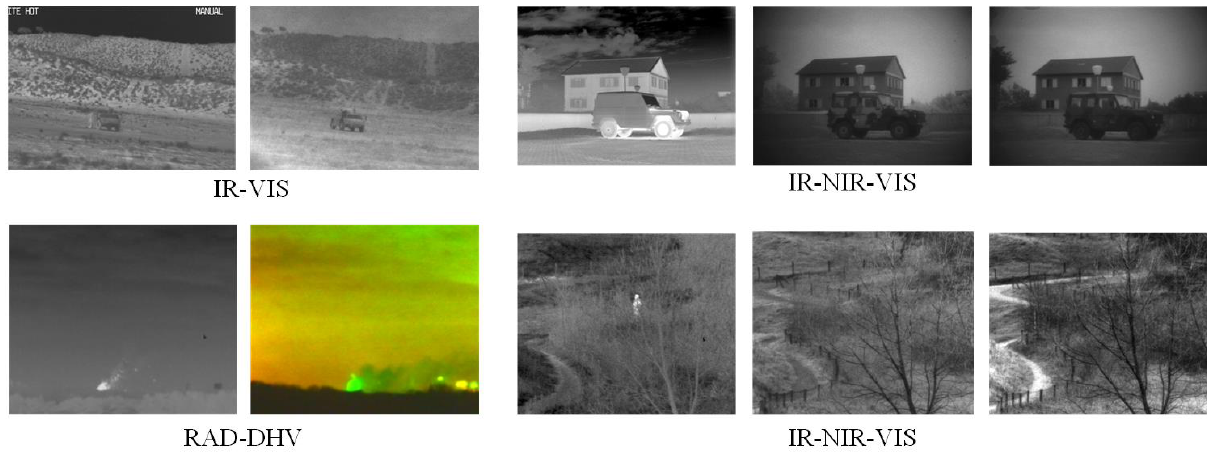
Figure 5. Illustration of examples in TNO. In different imaging modalities, the foreground and background are emphasized according to their temperature states. For instance, the texture features of the object are not clear in the night visible image (upper right), or even the objects are not